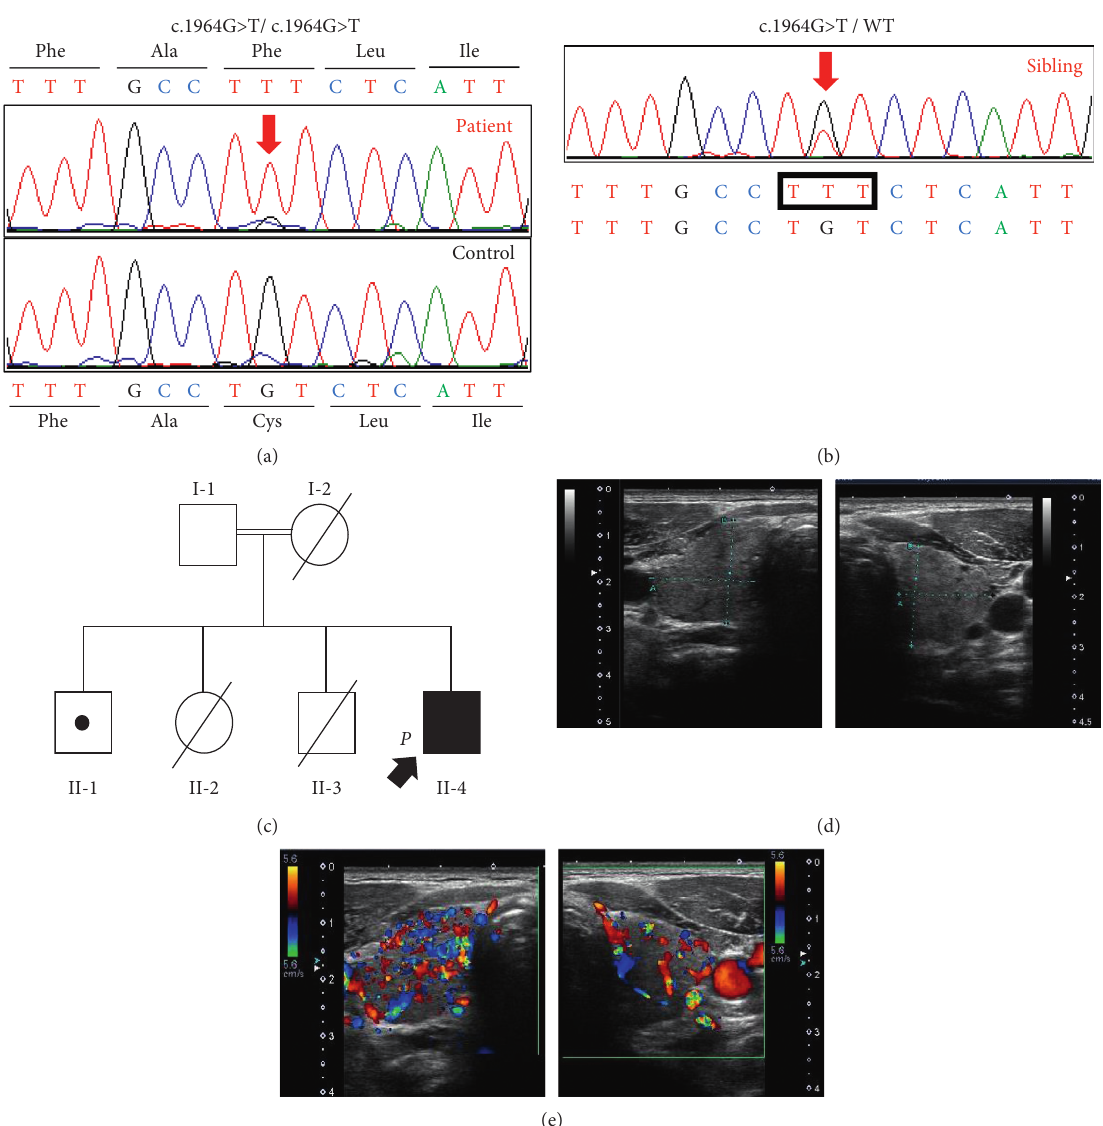
Figure 1: Discernment of a TPO mutation. (a) Partially electrophoretic pattern of the discerned TPO mutation. The patient had a homozygous novel missense mutation (p.Cys655Phe, red arrow). (b) Partially electrophoretic pattern of the discerned TPO mutation. Elder brother (Figure 1(c), II-1) had a heterozygous novel missense mutation (p.Cys655Phe, red arrow). (c) Family tree of the patient. Filled symbols with a P in the lower left indicate the proband. The dots in the squares indicate carriers. We have not examined the parents and siblings of the proband for mutations. Image inspection result of the patient. (d) Ultrasonography showed mild goiter in the patient. (e) Internal echoes were uneven, and increased blood flow was observed on a color Doppler